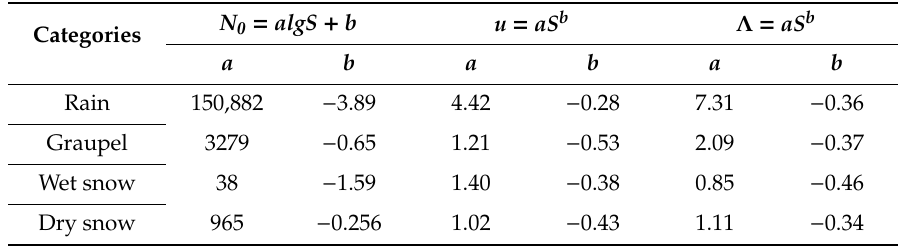
Table A2. The fitting relationship between the Gamma parameters ( N 0 , u , Λ ) and the precipitation rate S